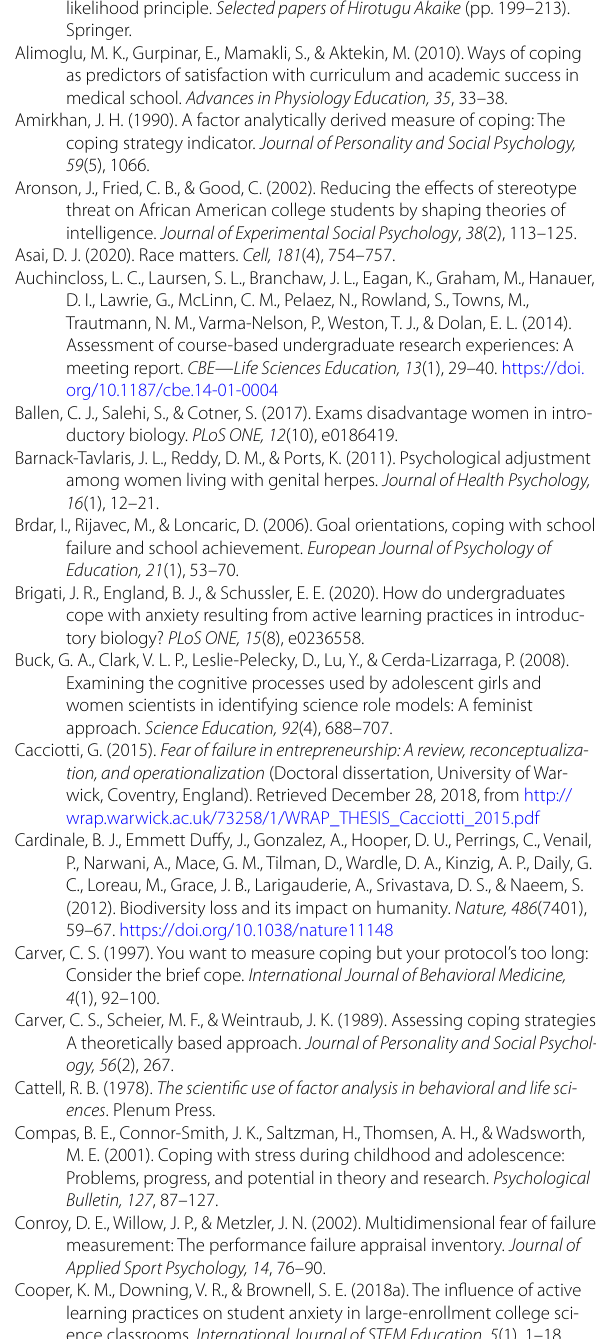
Additional file 1: Table S1. Definitions of proposed dimensions. Details of previous coping measures. Table S2. Source of items used in coping models. Table S3. Results of independent samples t-tests comparing demographic factors across samples. Table S4. Correlations between latent factors of coping behaviors model. Table S5. Correlations between latent factors of coping styles model. Table S6. Reliability of coping dimensions across samples and models. Supplementary Discussion: Dropped